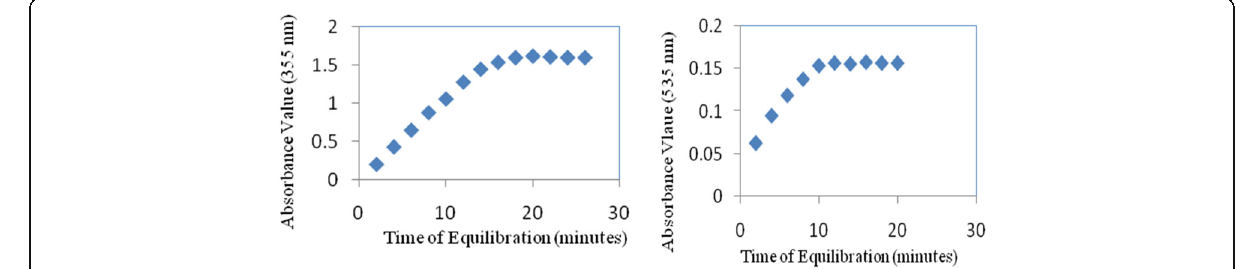
Fig. 4 Variation of absorbance as a function of time of equilibration at 355 and 550